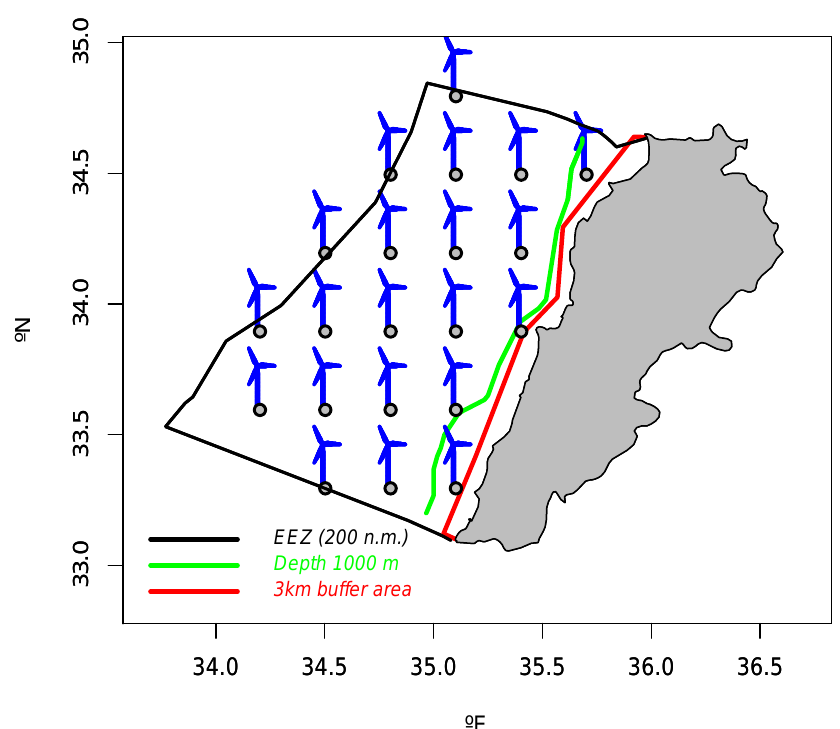
Figure 3. Lebanese exclusive economic zone, 1000 m depth boundary, and buffer